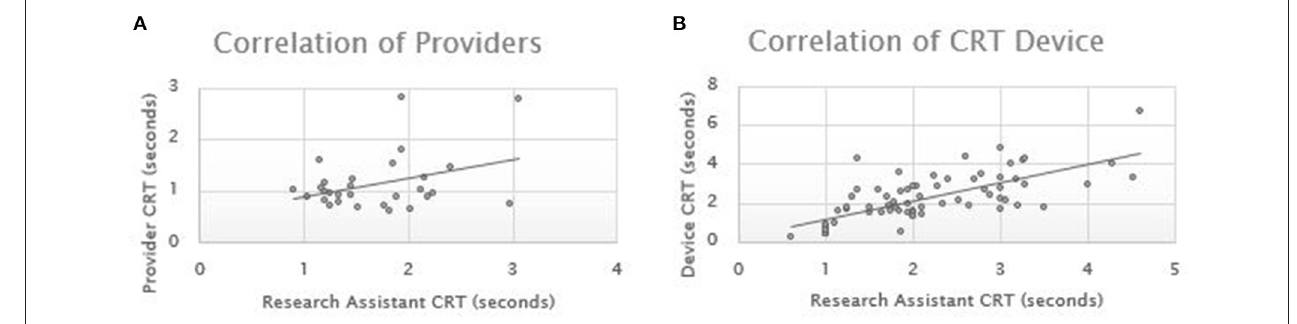
FIGURE 2 | Capillary refill time correlation. CRT, capillary refill